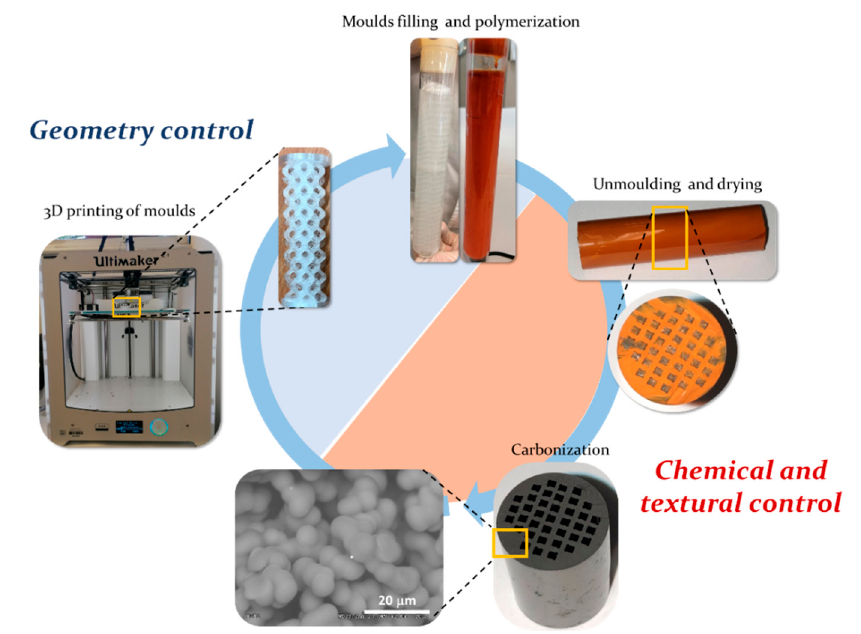
Figure 1. Scheme of the manufacture of 3D printed integral carbon monoliths with controlled geometry and chemical and textural properties.